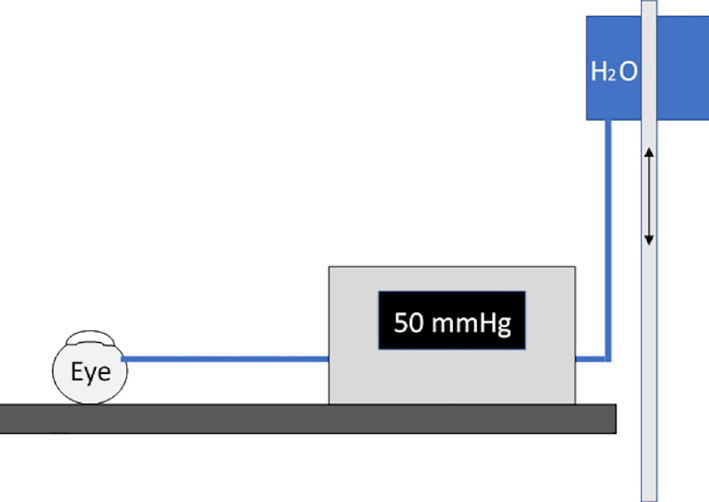
Fig 2. Setup: A ppv trocar was inserted pars plana into the vitreous cavity and connected to a height-adjustable infusion. By changing the height of infusion stand the intraocular pressure could be changed and checked with the vital data